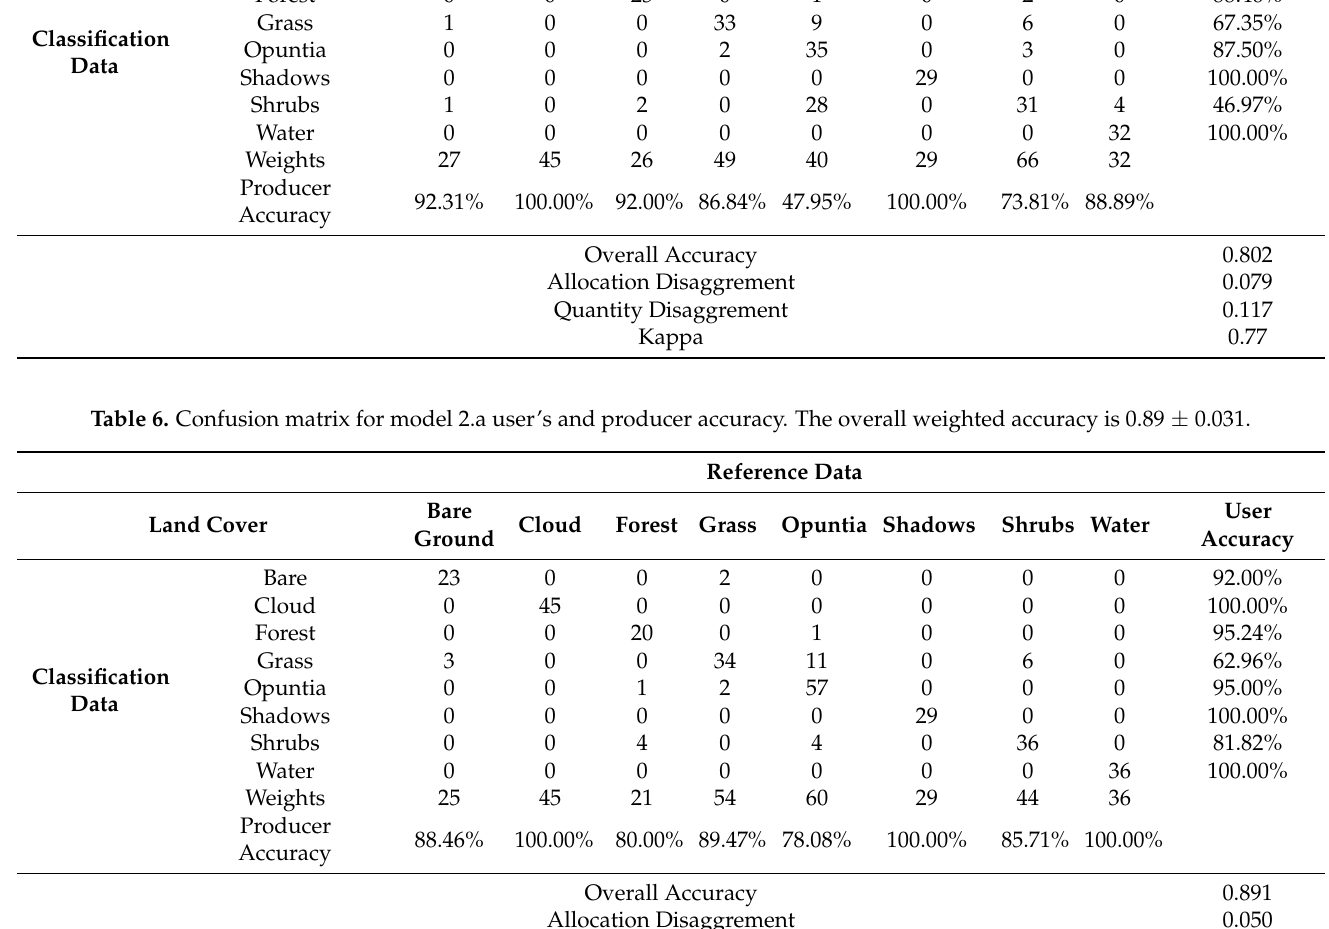
Table 5. Confusion matrix for model 1.a user’s and producer accuracy. The overall weighted accuracy is 0.80 ± 0.038. Land Cover